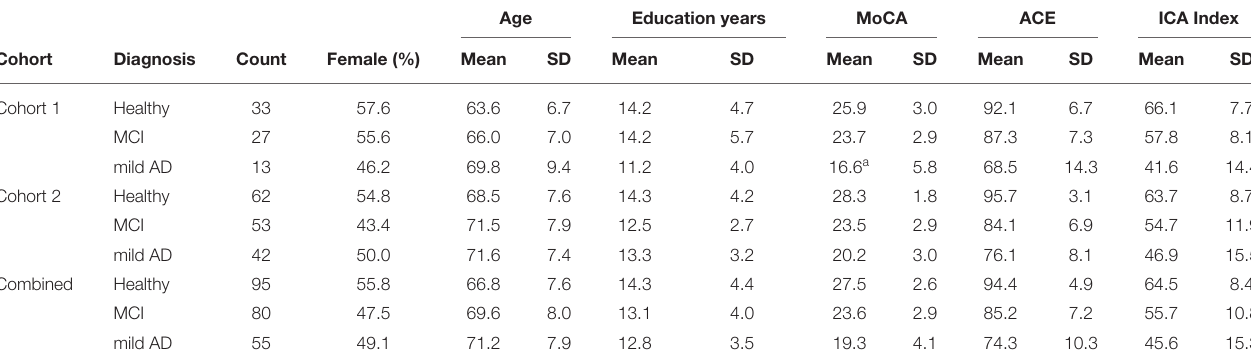
TABLE 1 | Summary of demographic information, and cognitive test scores of recruited participants. Age Education years MoCA ACE ICA